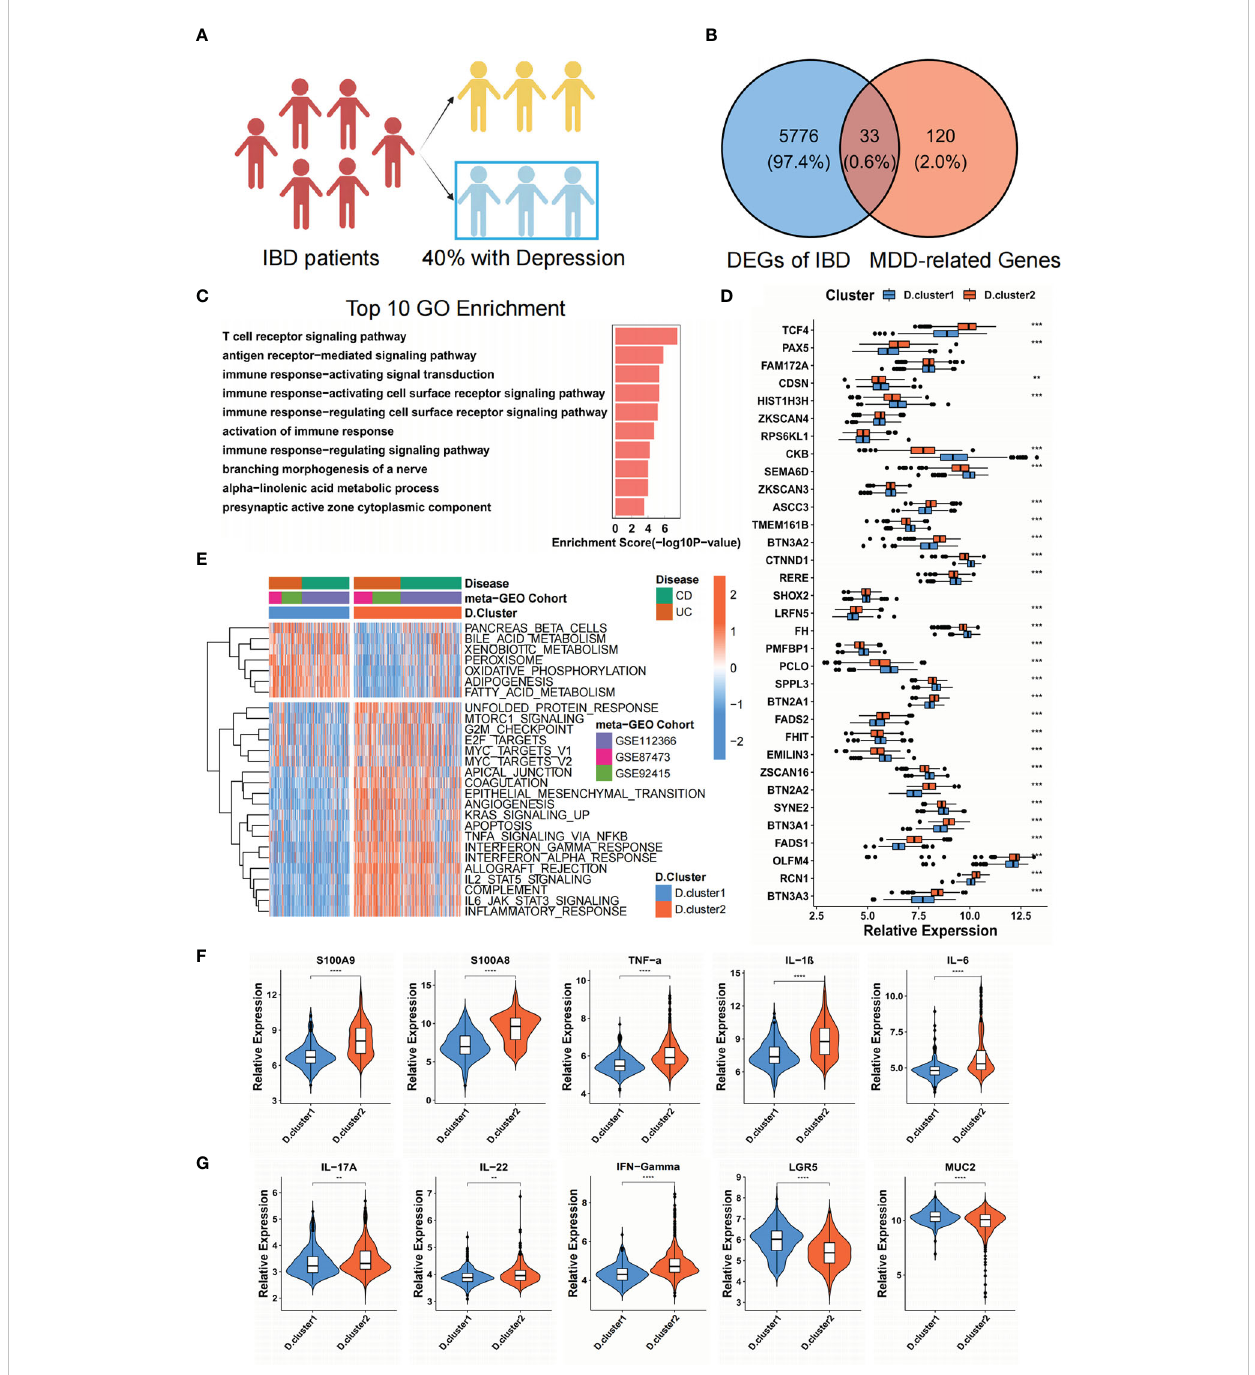
FIGURE 2 Identi fi cation of two molecular subtypes by 33 genes that drive depression in IBD patients. (A) The schematic representation of the proportion of IBD patients with or without depression. (B) The 33 core genes that might drive depression in IBD patients were shown in the Venn diagram. (C) Functional annotation for 33 core genes using GO enrichment analysis. (D) The difference in mRNA expression levels of 33 core genes between two molecular subtypes. (E) Heatmap shows the GSVA score of representative Hallmark pathways curated from MSigDB in distinct molecular subtypes. The GEO cohort composition (GSE87473, GSE92415, GSE112366) were used as sample annotations. (F, G) The mRNA expression levels of intestinal in fl ammatory markers (S100A8, S100A9, TNF- a , IL-1B, IL-6, IL-17, IL-22, INF- g ) and barrier function markers (LGR5, MUC2) between two molecular subtypes. The asterisks represented the statistical P-value (**P < 0.01; ***P < 0.001; ****P <